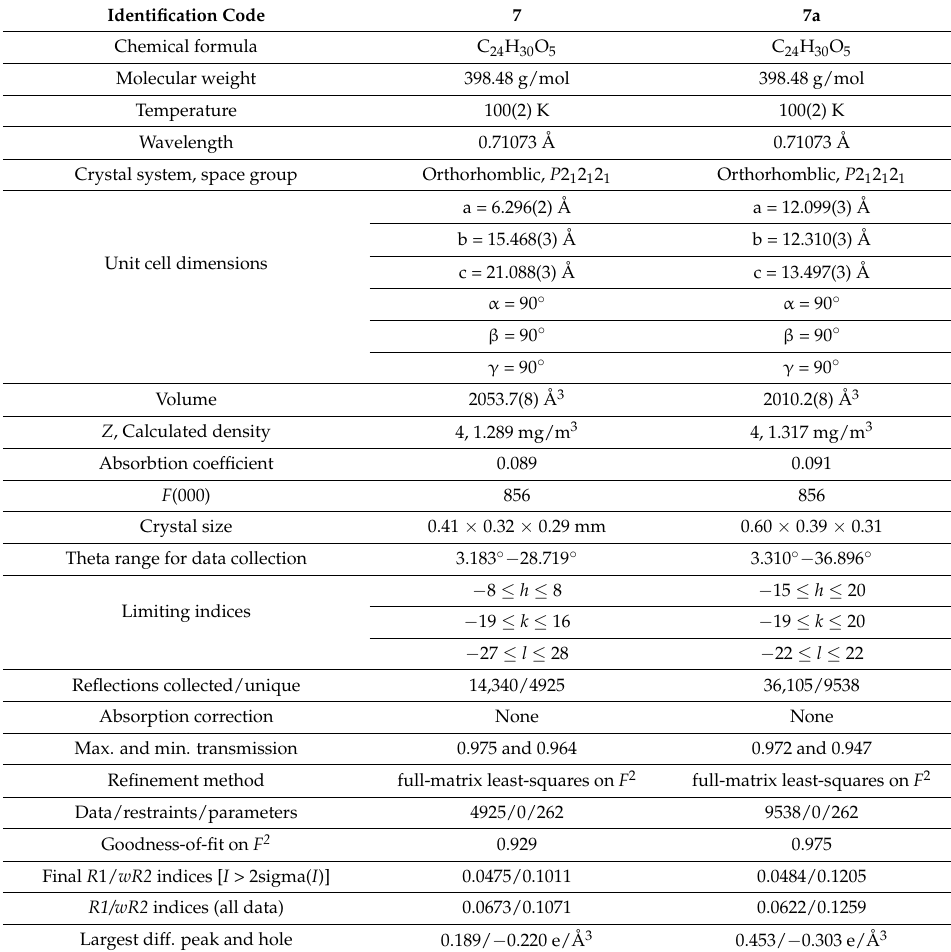
Table 6. Summary of crystallographic data and structure refinement for the isomeric 9(11)-enesters (7 α ,17 α )- 7 and (7 β ,17 α )- 7a